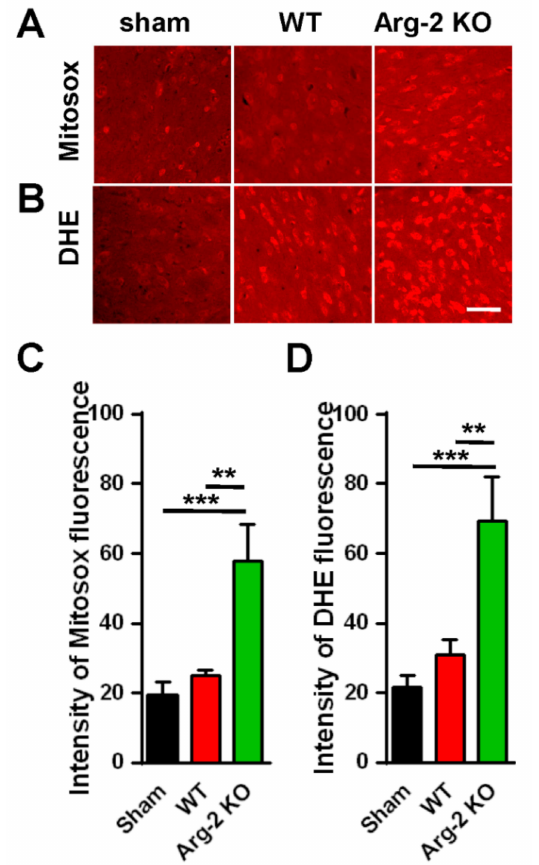
Figure 6. Production of reactive oxygen species (ROS) in the spinal cords of mice following surgery. ( A , B ) Upper panel shows the immunohistochemical images of spinal cord sections with the Mitosox ROS antibody, indicating an increased production of ROS in the mitochondria of SNT WT and Arg2 KO mice. The most robust expression of ROS was observed in Arg2 KO mice. The same result was obtained in spinal cord sections stained with Dihydroethidium (DHE), showing the formation of ROS in the cytoplasm (lower panel). Scale bar = 50 µ m. ( C , D ) ROS and mitochondrial ROS (mtROS) production in the spinal cord of the three groups on day 7 post-surgery was quantified by Image J. Data are presented as means ± SEM (one-way ANOVA with Tukey’s post hoc test, F (2,6) = 31.17 ( C ), F (2,6) = 30.53 ( D ). *** p < 0.001 and ** p < 0.01 versus